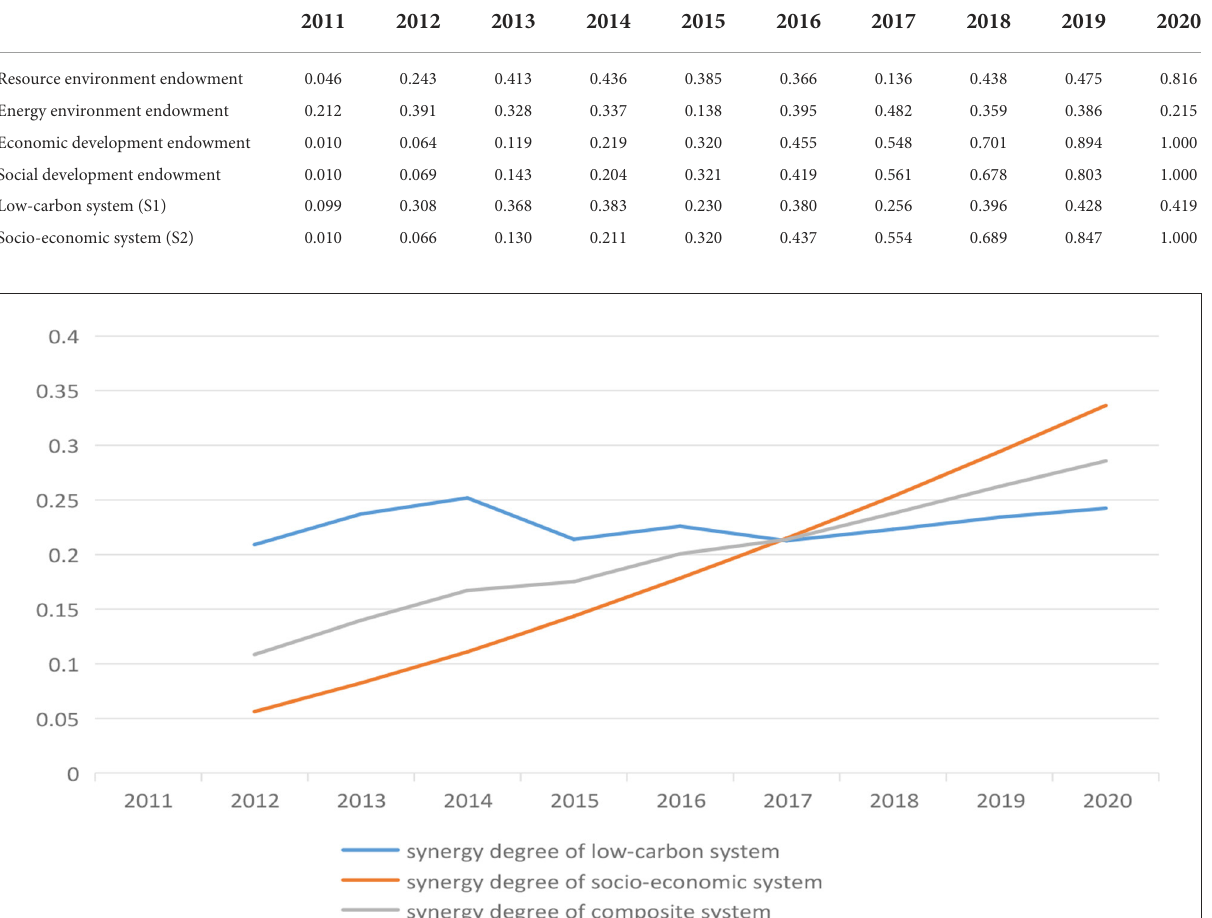
TABLE 9 The order degree of criteria layer and target layer in Anhui province from 2011 to 2020.